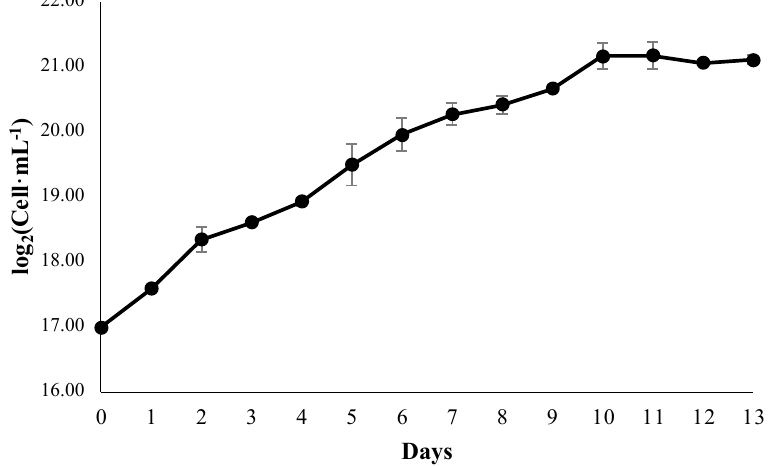
Figure 1. Growth kinetics of P. cruentum (log 2 (cell · mL − 1 )). Differences in culture conditions generate variability in growth kinetics and cell concentrations reported for P. cruentum (2,358,899 ± 336,481 cells mL − 1 ). The results agree with another report, since they obtained an average cell concentration of 3,220,000 ± 280,000 cells mL − 1 on day 8 of culture, which marked the beginning of the stationary phase [52]. Furthermore, day 10 of culture was defined as the starting point of the stationary phase of P. purpureum (2.3 g/L) [34], and data that support the growth kinetics are outlined in the current